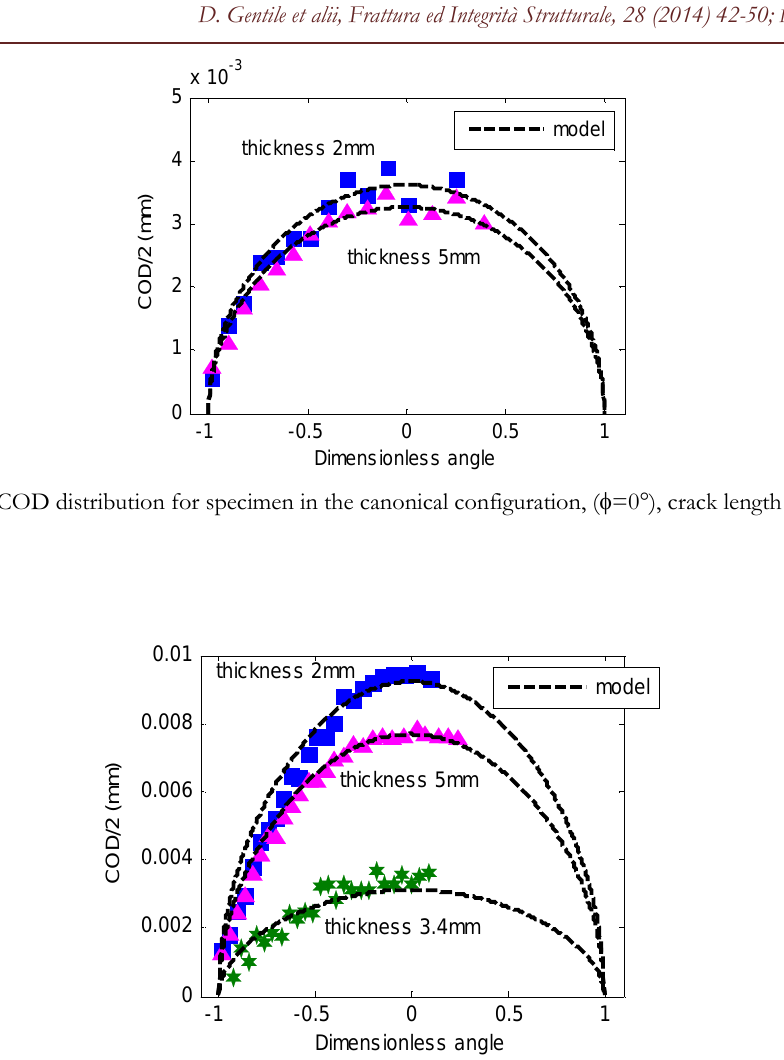
Figure 6: COD distribution for pipe with different thickness: crack length 2  90°.